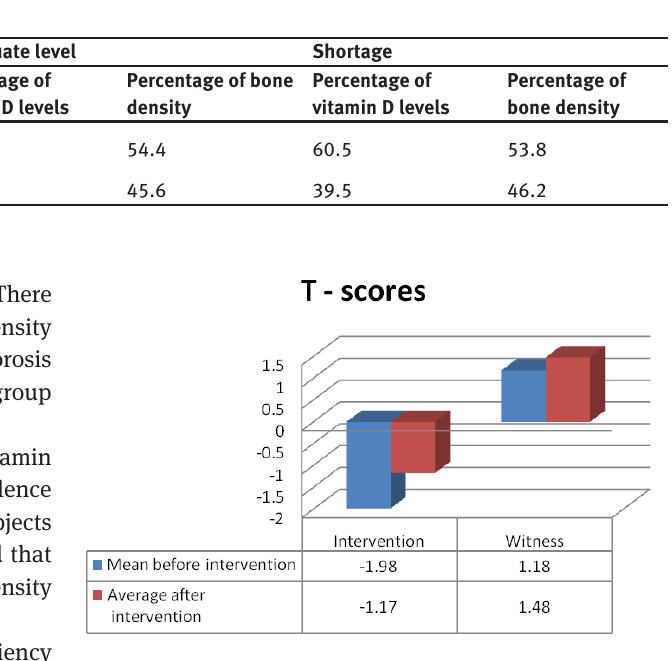
Figure1: Line chart of T-score changes of bone density in patients referred to The Bone Density Clinic of Semnan’s Kowsar Hospital in 2018, by intervention and control